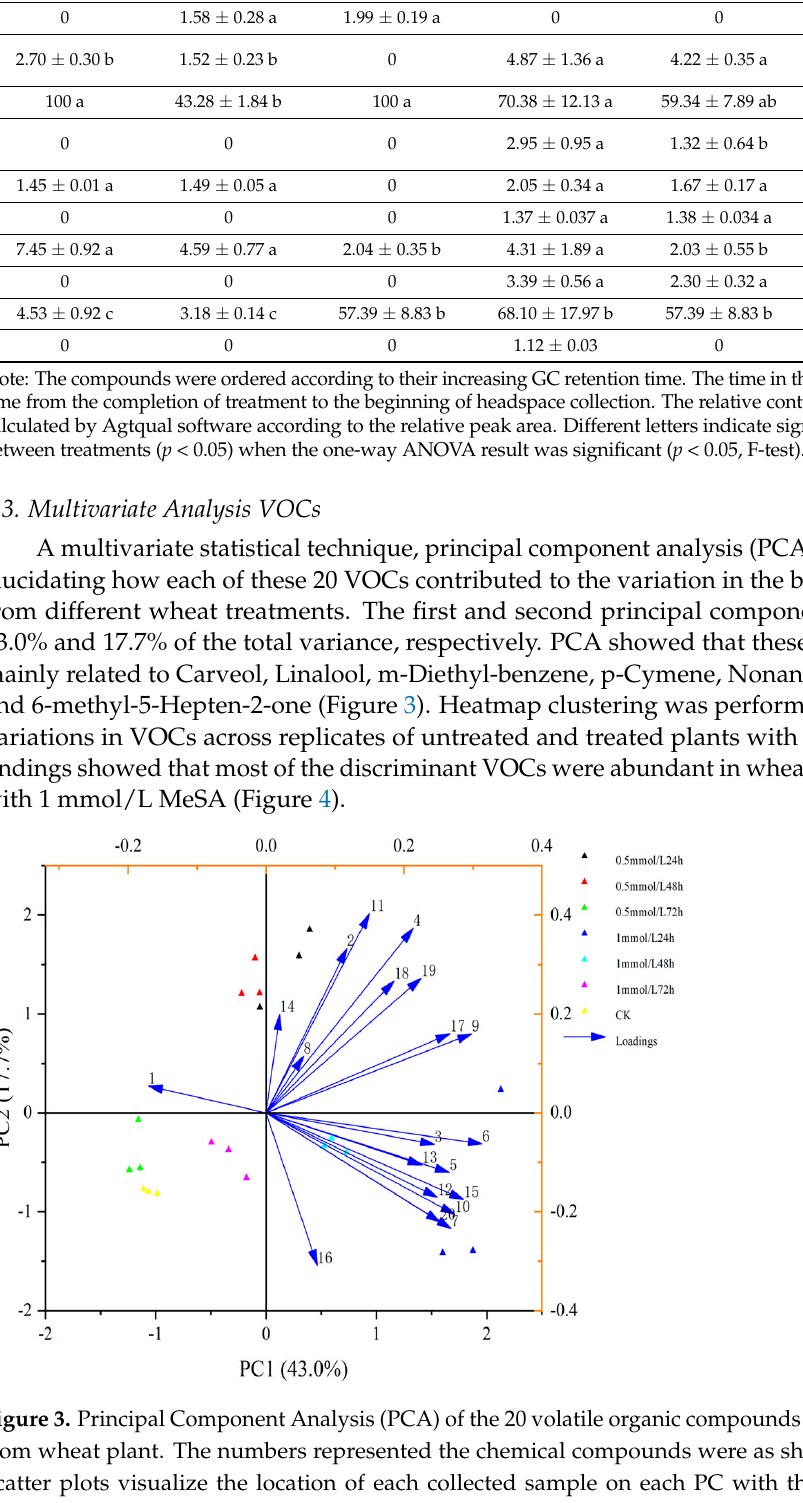
Figure 4. Heatmap clustering showing the abundance (in decreasing color intensity) of the most discriminant VOCs across replicates of wheat plants. Alcohols (20, 13, 10, 15, 2), aldehyde (12, 14, 17, 11), hydrocarbon (8, 14, 1, 7, 6, 18, 9, 3, 19, 4), keto (5), ester (16). The numbers represented the chemical compounds were as showed in Table 1. 2.4. Gas Chromatography-Electroantennogram Detection